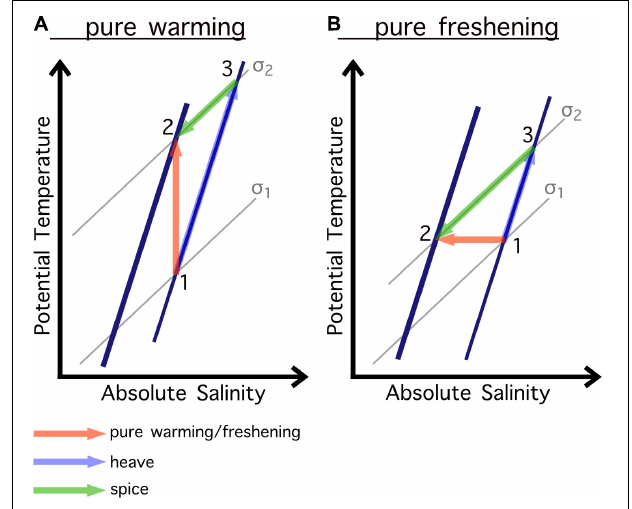
FIGURE 2 | T-S relation schematic for a pure warming process (A) and a pure freshening process (B) for a subtropical stratification (adapted from Bindoff and McDougall, 1994; Häkkinen et al., 2016). Thin blue line indicates initial thermocline, thick blue line the new thermocline. Gray lines show the potential density surfaces ( σ 1 as the initial density surface and σ 2 as the density surface at the same depth after the warming/freshening process with σ 2 being smaller and thus lighter than σ 1 ). 1 indicates the initial starting point, 2 reveals the T-S condition at the same depth after warming/freshening. Orange arrows (1–2) denote the warming/freshening process, green arrows indicate the spice component (3–2) and blue arrows the heave component